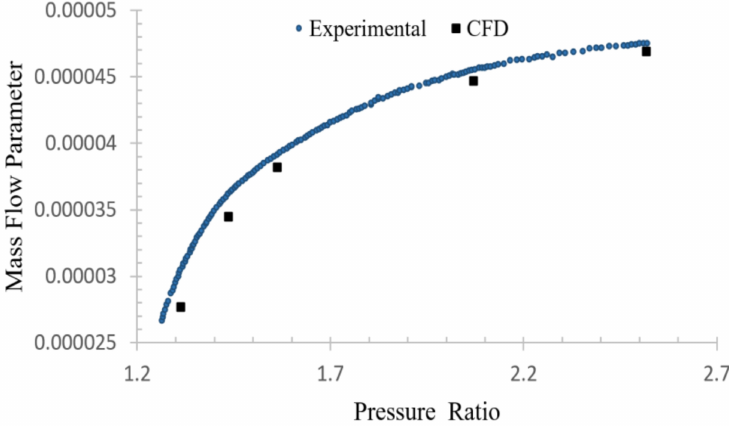
Figure 2. Comparison of computed and measured mass flow parameter against pressure ratio.